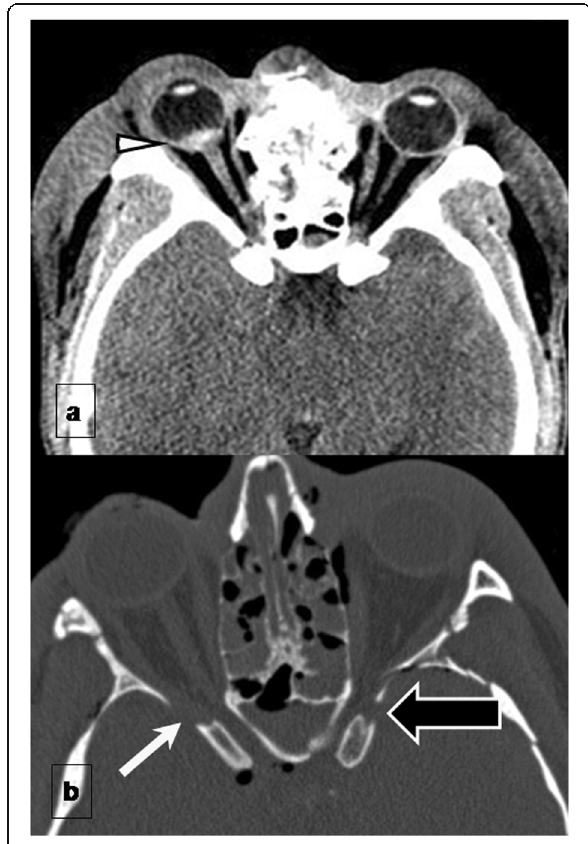
Fig. 2 Complications of facial fractures. a Intraorbital complications. Axial unenhanced CT at the level of the mid-orbit shows a hematoma of the posterior pole of the globe affecting optic nerve papilla (arrowhead) in a naso-orbito-ethmoid fracture (not shown). The patient developed traumatic optic neuropathy with right blindness. b Neural foramina complications: superior orbital syndrome. CT shows left superior orbital fissure narrowing (black arrow) with respect to the normal right side (white arrow) by Le Fort III fracture with external wall displacement that can affect CN III, CN IV, CN V1, and CN